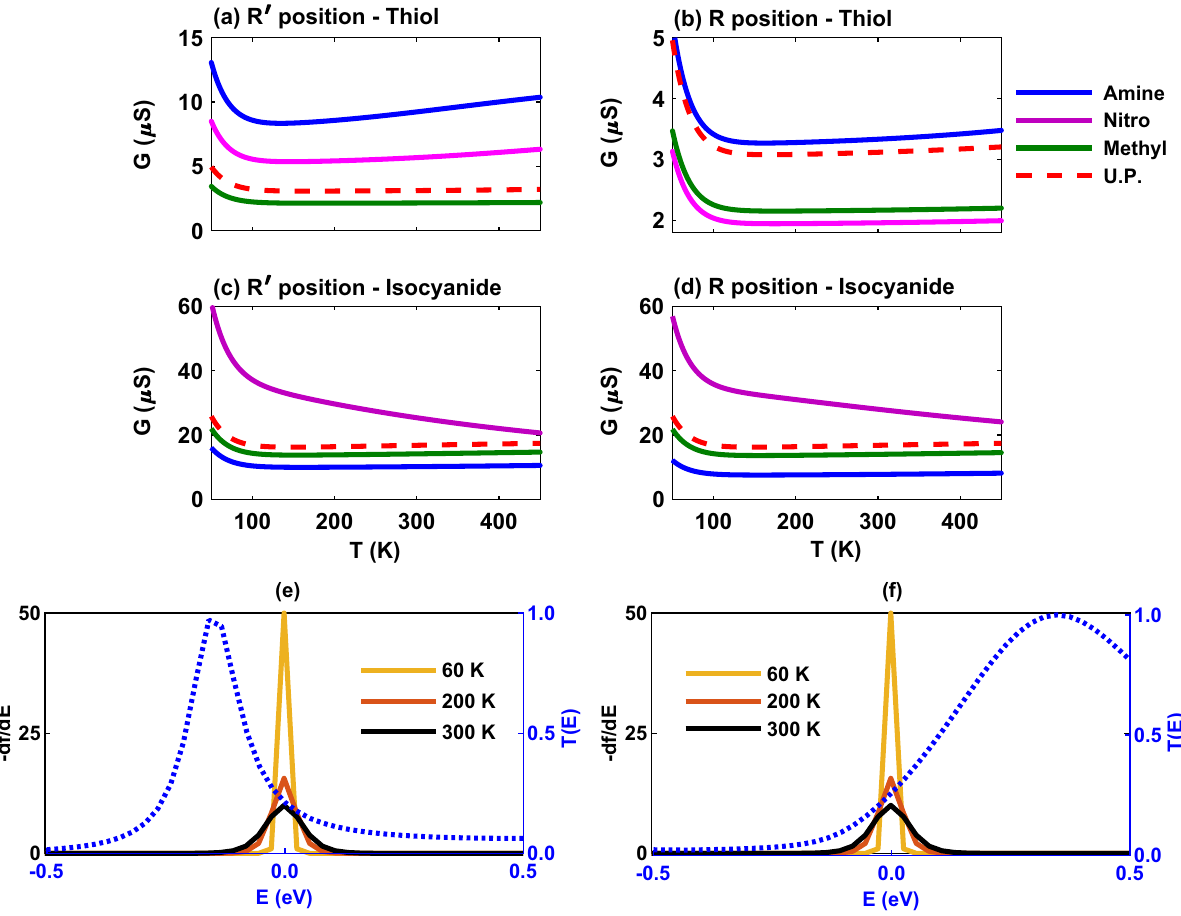
Figure 7. The electrical conductance of the Au-anthracene-Au junction as a function of temperature when the thiol anchoring group mediates molecule-electrode contact in the presence of amine (blue), nitro (magenta) or methyl (green) as the side group in ( a ) R ′ and ( b ) R positions. The electrical conductance of the isocyanide- terminated junction with amine (blue), nitro (magenta) or methyl (green) side group in ( c ) R ′ and ( d ) R positions. Moreover, the electrical conductance of the unperturbed (U.P.; red) system in the absence of side groups is drawn as a reference. Examplar representation of the Fermi derivative peak ( − df / d ε in the left axis; T = 60, 200, 300K ) and transmission coefficient peak ( T (ε) in the right axis; blue dotted curve) for the molecule anchored with ( e ) thiol and ( f ) isocyanide units with amine side group in the R ′